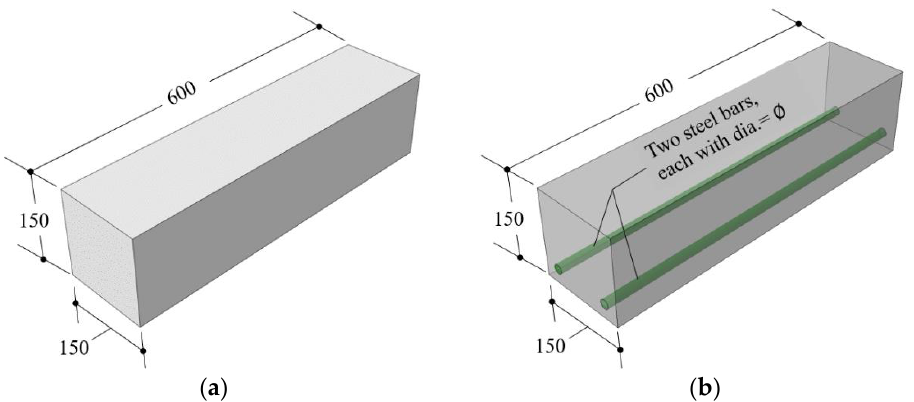
Figure 2. The details of ( a ) B1 and ( b ) B2 – B6 (Dimensions are in